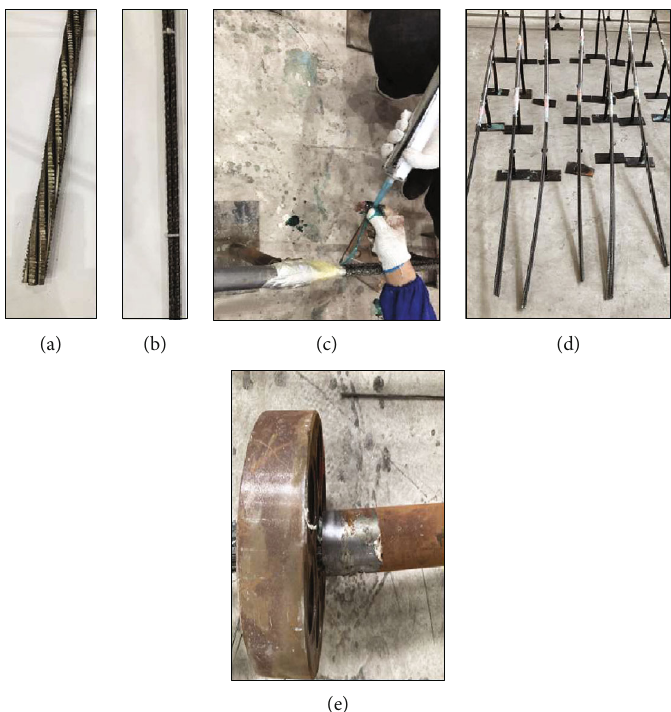
Figure 1: The procedure for making the BFRP anchor cable: (a) the steel strand, (b) the BFRP tendon, (c) injecting epoxy resin adhesive, (d) the “ BFRP-connector-strand ” illustration, and (e) the end